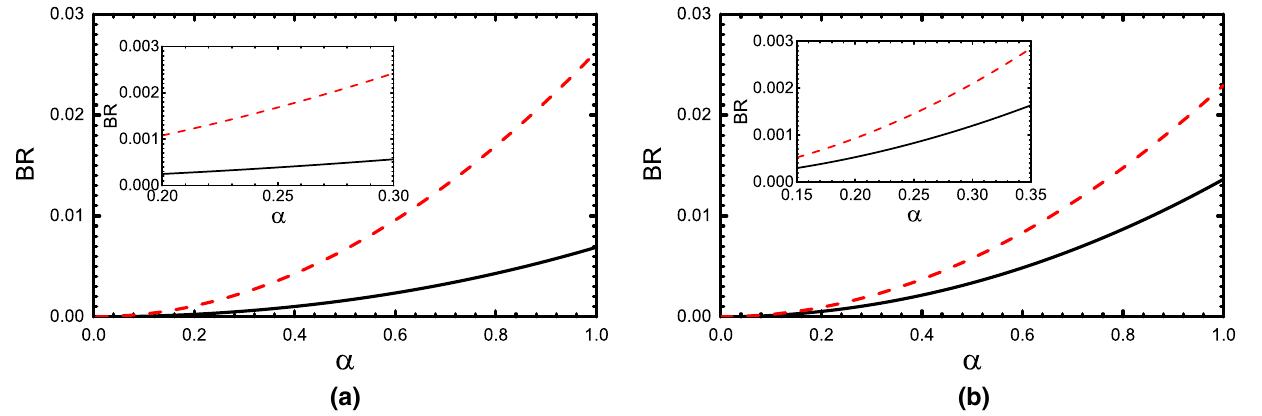
the branching ratios of h c → γη ( solid line ) and γη (cid:3) ( dashed line ), respectively. The η – η (cid:3) mixing angle θ P = − 14 . 4 ◦ from Ref.